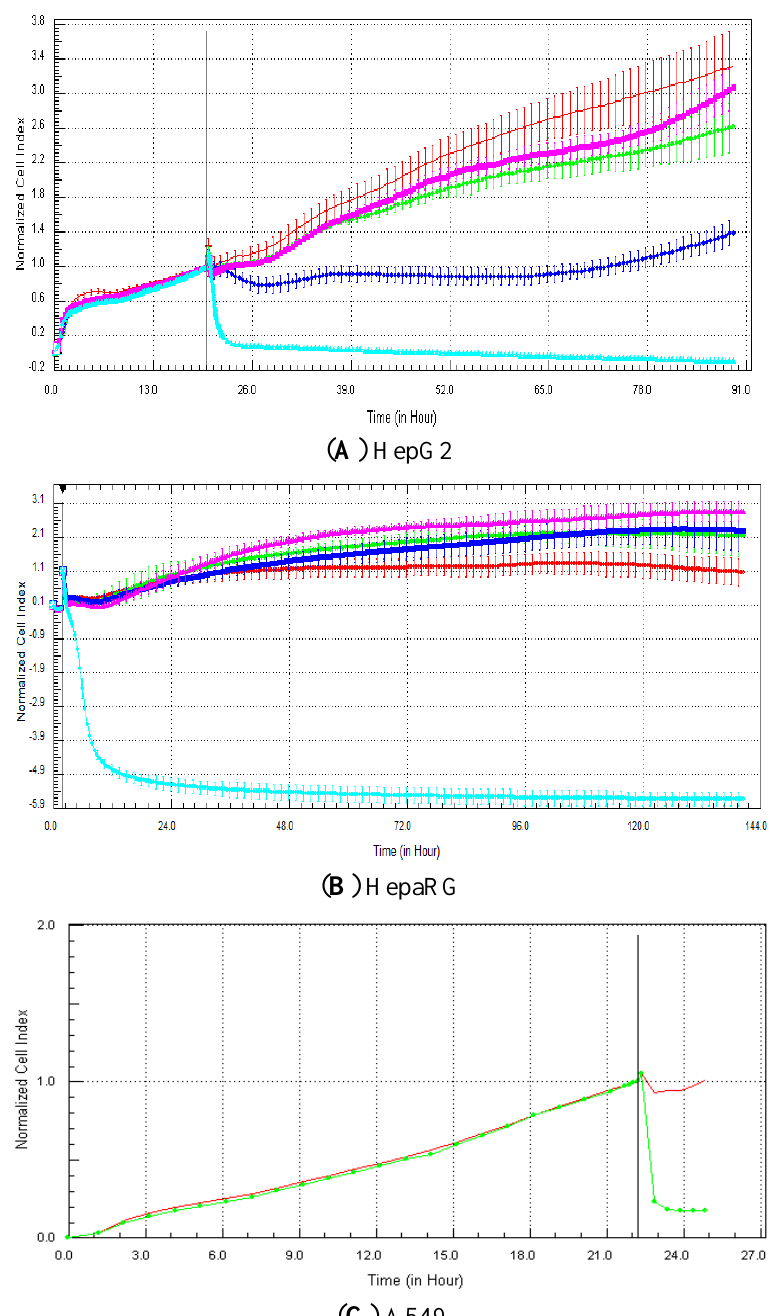
Figure 3. Effect of tamoxifen (calcium modulator) on cell index curves (RTCA) in HepG2, fresh HepaRG and A549 cells. HepG2 ( A ) and HepaRG ( B ) cells were exposed for at least 72 h to 0 (0.5% DMSO, red curve), 0.1 (green curve), 1 (purple curve), 10 (dark blue curve) and 100 (light blue curve) µM and A549 cells to 0 (control DMSO, red curve) and 20 µM (green curve) of tamoxifen ( C from Abassi et al. [9]). Cell indexes were normalized with the last time point before compound addition. Panels A and B: each data point was calculated from triplicate values (except for control cells n = 6). Data represent the average ± standard deviation (except for panel C). The normalized time point is indicated by the vertical line. For more details, please refer to the Materials and Methods